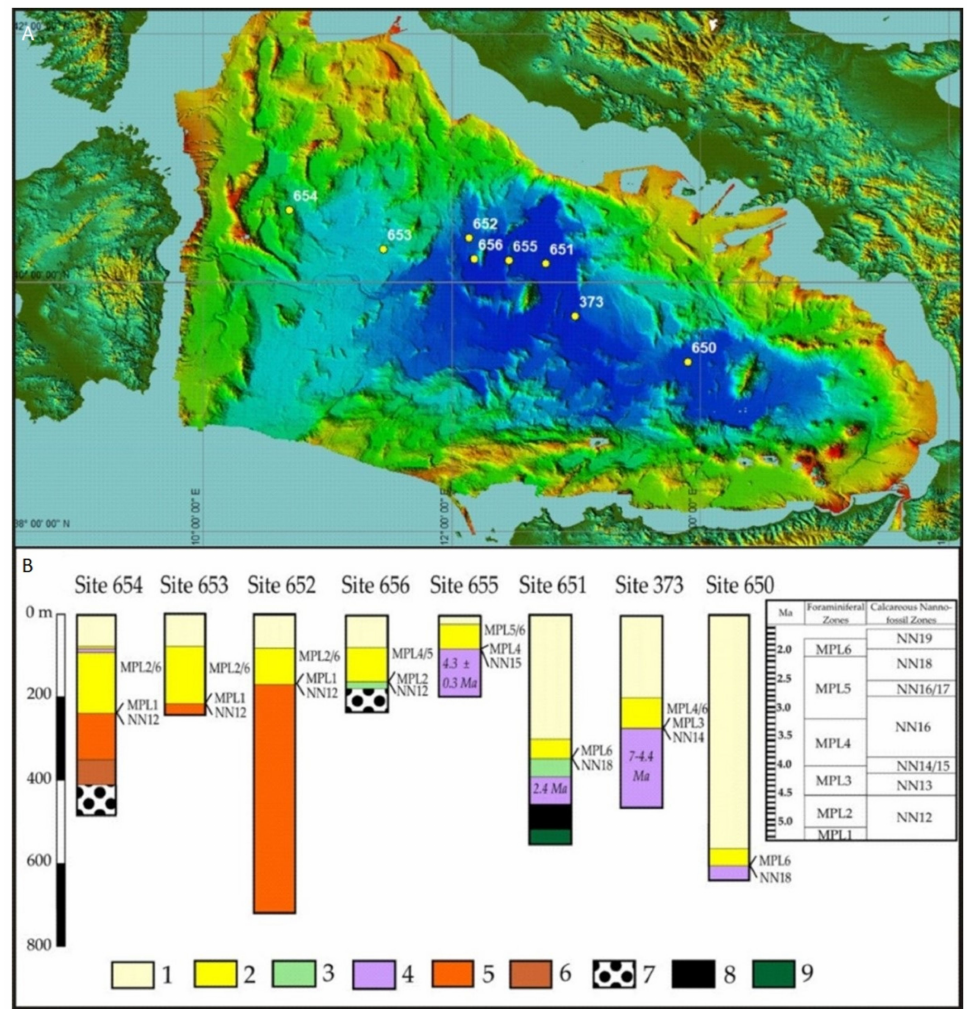
Figure 7. ( A ) Index map of Italy and Vavilov basin and DSDP and ODP well sites ( B ) Stratigraphic logs of the DSDP and ODP sites. ( 1 ) Pleistocene deposits; ( 2 ) Pliocene deposits; ( 3 ) dolostones; ( 4 ) basalts; ( 5 ) Messinian deposits; ( 6 ) Tortonian deposits; ( 7 ) conglomerates; ( 8 ) breccias; ( 9 ) serpentinized peridotites; after